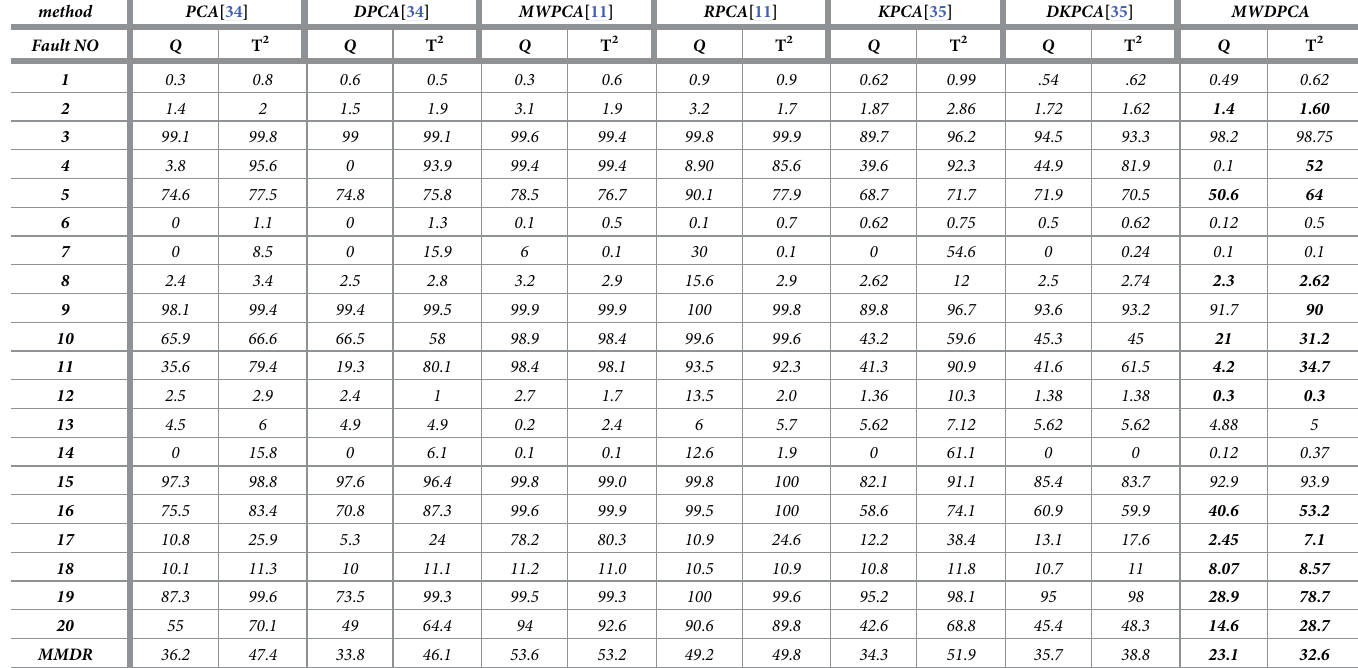
Table 3. Comparison of MDR for MWDPCA with other methods.